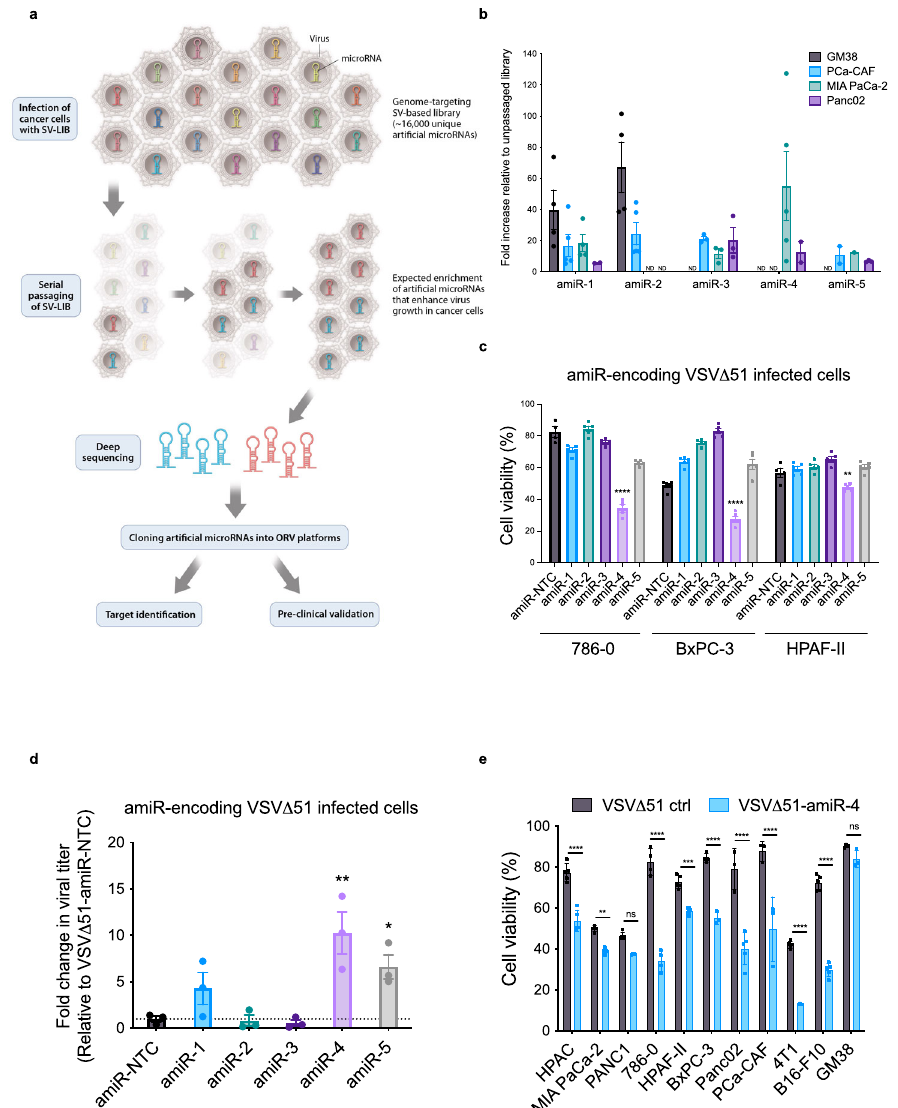
Fig. 1 Screen of a Sindbis virus-based arti fi cial microRNA library identi fi es arti fi cial miRNA-4 as a pro-oncolytic virus amiRNA sequence. a Schematic fl owchart for the selection of pro-viral amiRNAs under pancreatic tumour cell selection. b Fold increase in deep sequencing amiRNA hits of the top fi ve most enriched amiRNAs, compared to the unpassaged library in GM38, pancreatic (PCa) CAF-like fi broblasts, MIA PaCa-2 and Panc02 cells. Data displayed as mean ± SEM of fi ve technical replicates. Full targeted RNA-sequencing datasets are included in Supplementary Data 1. c Relative percentage (%) of cell viability of 786-0, BxPC-3 and HPAF-II cells infected for 48 h (786-0 and BxPC-3) or 72 h (HPAF-II) with indicated amiRNA-expressing viruses at MOIs 1, 5 and 3, respectively, compared to uninfected cells. Results displayed as mean ± SEM of fi ve biological replicates. Differences between amiRNA- expressing viruses and control virus were assessed by two-way ANOVA with Dunnett ’ s multiple comparisons test (95% con fi dence intervals [CI]), ** P = 0.0048, **** P < 0.0001. d Relative fold change in titers of amiRNA-expressing VSV Δ 51 viruses compared to VSV Δ 51-amiR-NTC following ex vivo infection of patient-derived pancreatic tumour cores. Data represent mean values ± SEM of three biological replicates. One-way ANOVA with Dunnett ’ s multiple comparisons test (95% CI), * P = 0.0392, ** P = 0.0013. e Cell viability of indicated cell lines after VSV Δ 51-amiR-NTC (VSV Δ 51 ctrl) or VSV Δ 51- amiR-4 infection (MOI 0.1; 48 h) compared to mock-infected cells was measured using the alamarBlue ® Assay. Data indicate the mean ± SEM of fi ve biological replicates. Two-way ANOVA with Sidak ’ s multiple comparisons test (95% CI), ns P > 0.05, ** P = 0.003841, *** P = 0.000125, **** P < 0.001. Source data are provided as a Source data fi